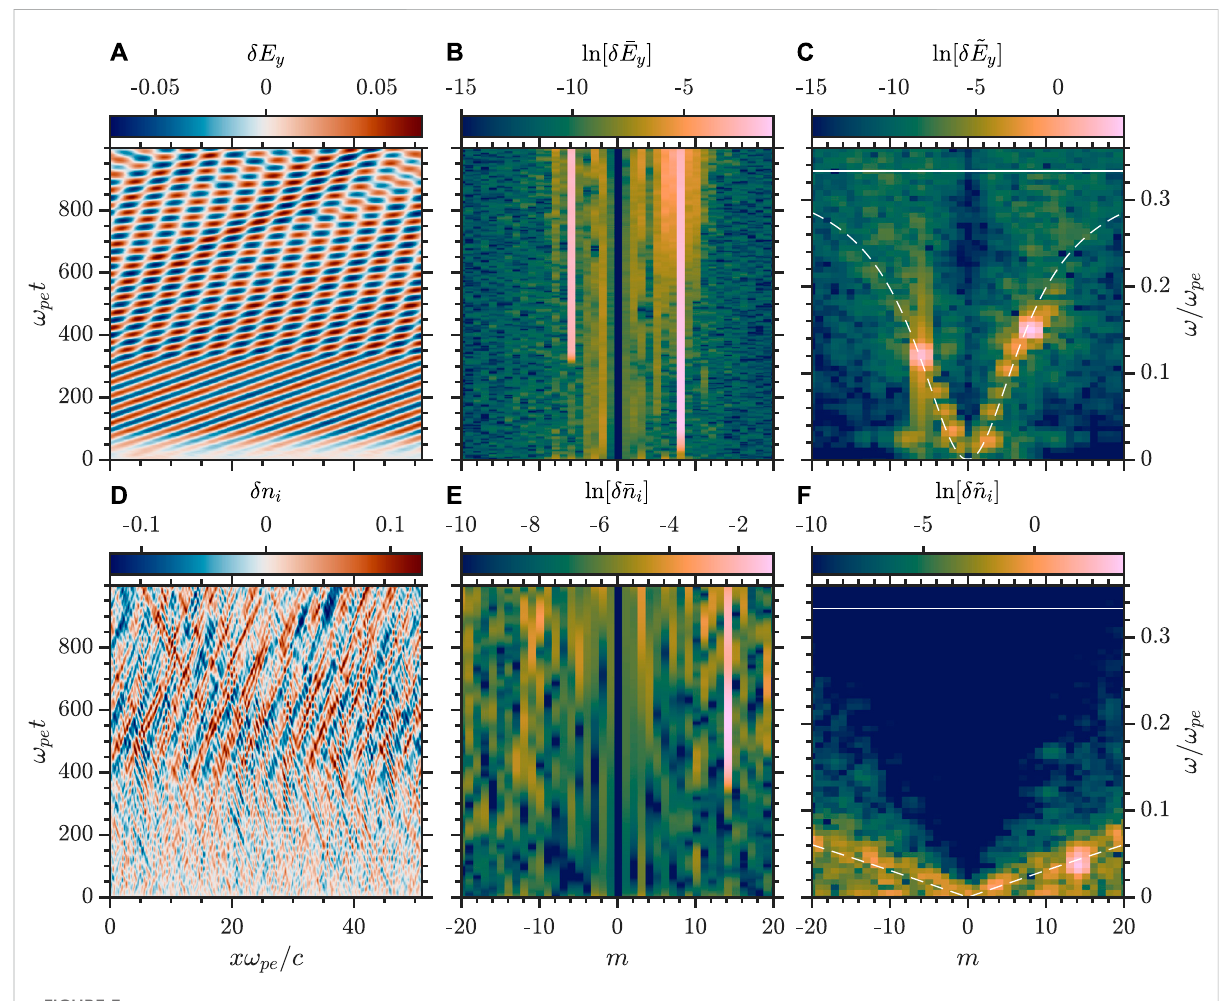
Single parametric decay of whistler wave with δ B w / B 0 =0.032 (A) , (B) , and (C) xt -space, mt -space, and m ω -space of δ E y , respectively (D) , (E) , and (F) xt -space, mt -space, and m ω -space of δ n i , respectively. Dashed curves indicate the whistler and IAW branches in (C) and (F) , respectively, and the solid line is ω ce / ω pe . The mode number m is related to the wave number by the relation k =2 π m / N x